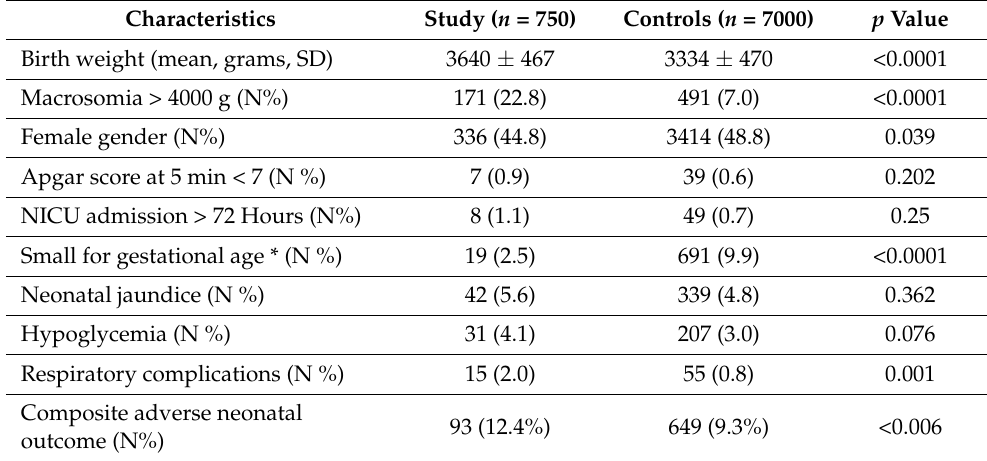
Table 4. Neonatal Characteristics and